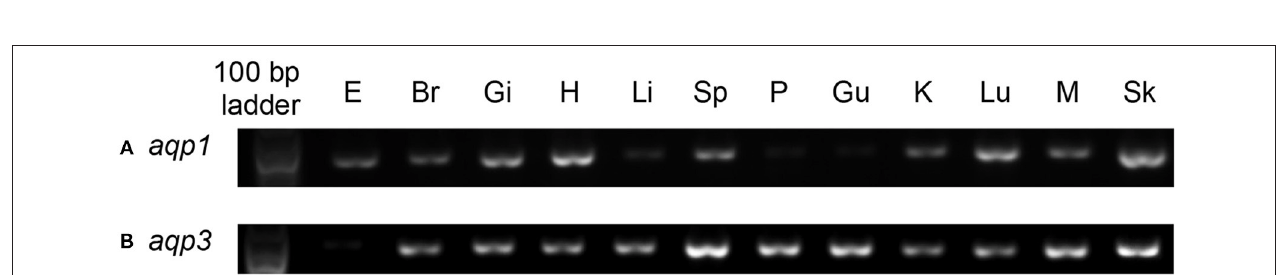
FIGURE 4 | A dendrogram of aquaporin 3 (Aqp3/AQP3) including Aqp3 of Protopterus annectens . The support for nodes is indicated by % bootstrap support (out of 1000) in the maximum likelihood analysis, employing the LG (Le and Gascuel, 2008) model of amino acid substitution. Ciona intestinalis Aqp3 is used as outgroup for the dendrogram.